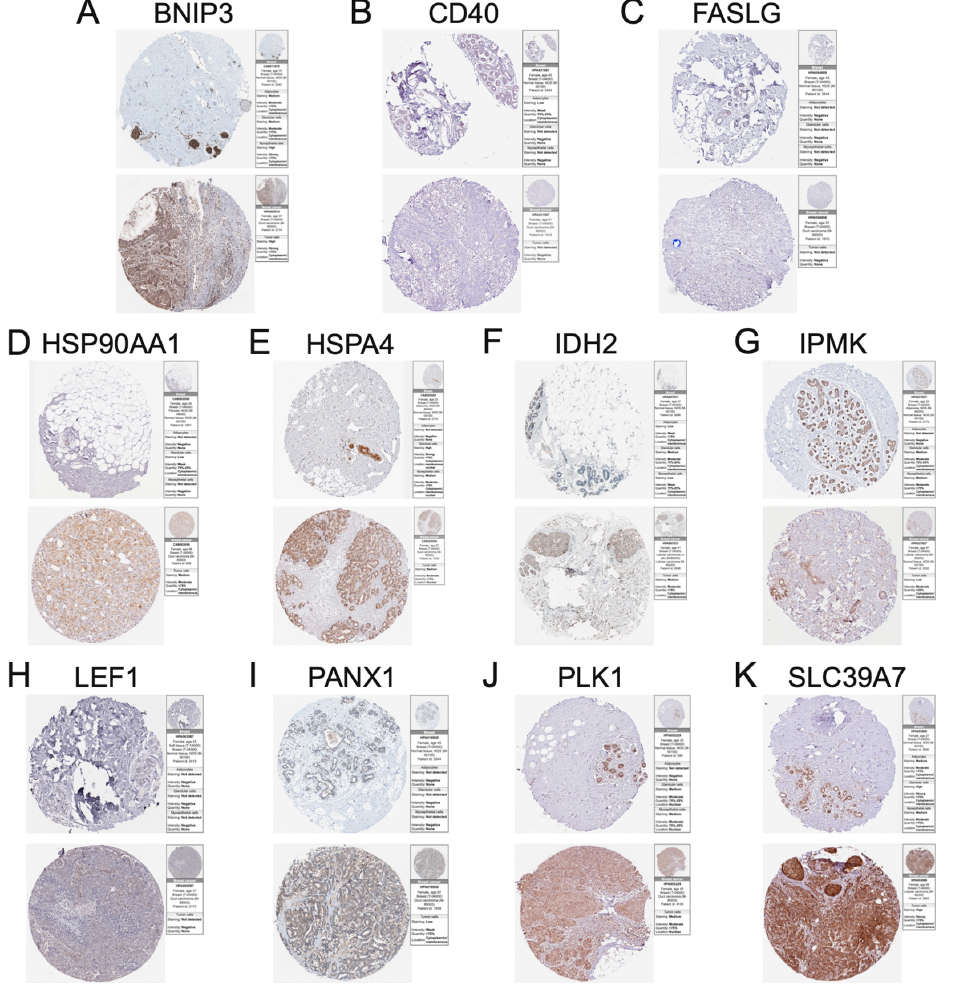
Figure 8. The results of immunohistochemistry showed the protein expression of BNIP3 ( A ), CD40 ( B ), FASLG ( C ), HSP90AA1 ( D ), HSPA4 ( E ), IDH2 ( F ), IPMK ( G ), LEF1 ( H ), PANX1 ( I ), PLK1 ( J ), and SLC39A7 ( K ) in breast cancer tissue and normal breast tissue.